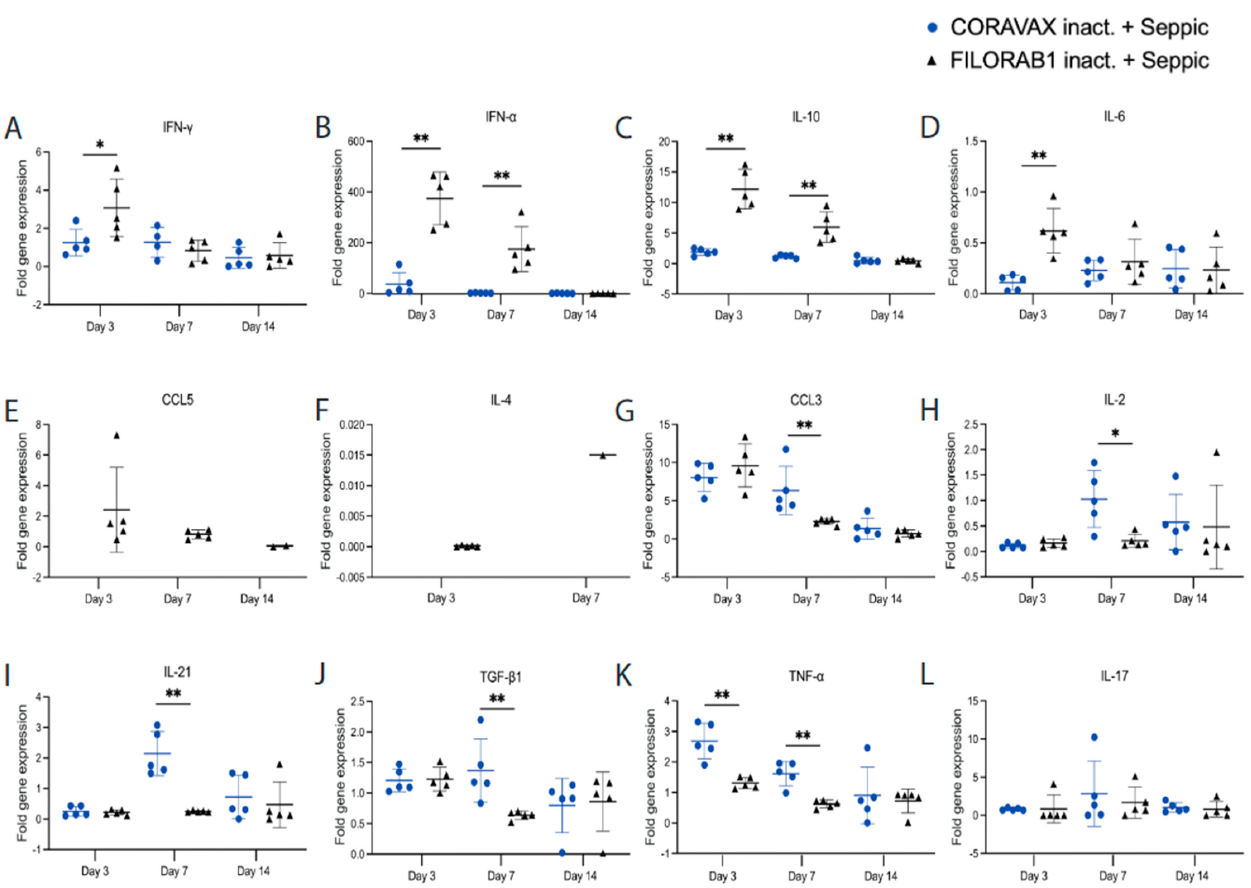
Figure 9. A single dose of CORAVAX immunization prevents a cytokine storm in the lungs . The CORAVAX vaccine group is shown in blue circles, and the FILORAB1 control group is in black triangles. Total RNA was extracted from the lungs of hamsters necropsied on days 3, 7, and 14 after challenge with SARS-CoV-2. Hamster ( A ) IFN- γ , ( B ) IFN- α , ( C ) IL-10, ( D ) IL-6, ( E ) CCL5, ( F ) IL-4, ( G ) CCL3, ( H ) IL-2, ( I ) IL-21, ( J ) TGF- β 1, ( K ) TNF- α , and ( L ) IL-17. Cytokine/chemokine mRNAs were quantified by real-time RT-PCR. γ -Actin mRNA was used as an internal control. Data are shown as fold change in gene expression compared to normal animals (unimmunized and unchallenged) after normalization. Data were analyzed using Mann–Whitney test for each time point (* p < 0.05; ** p < 0.01; *** p < 0.001).